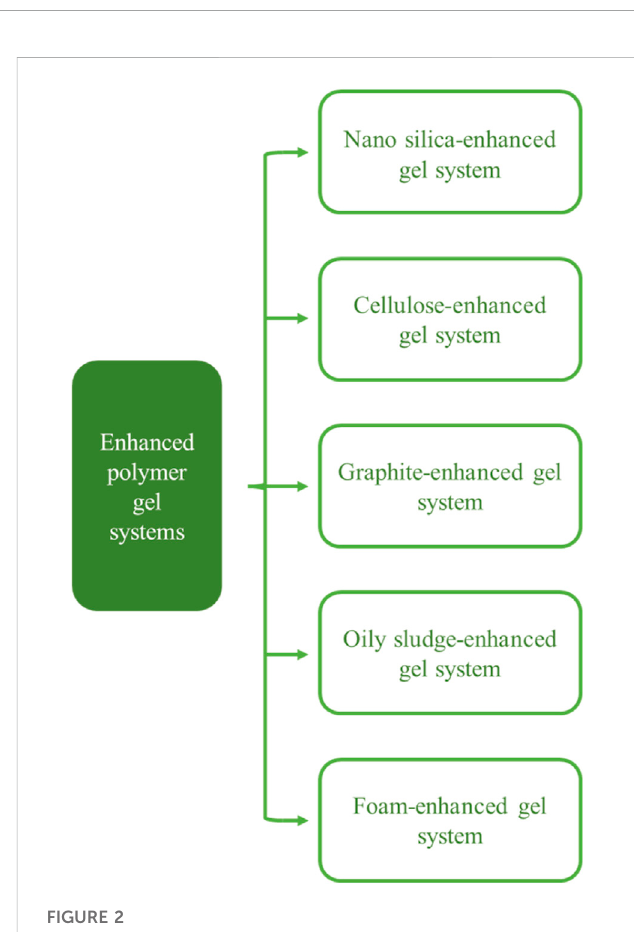
FIGURE 2 Classi fi cation of the enhanced polymer gel